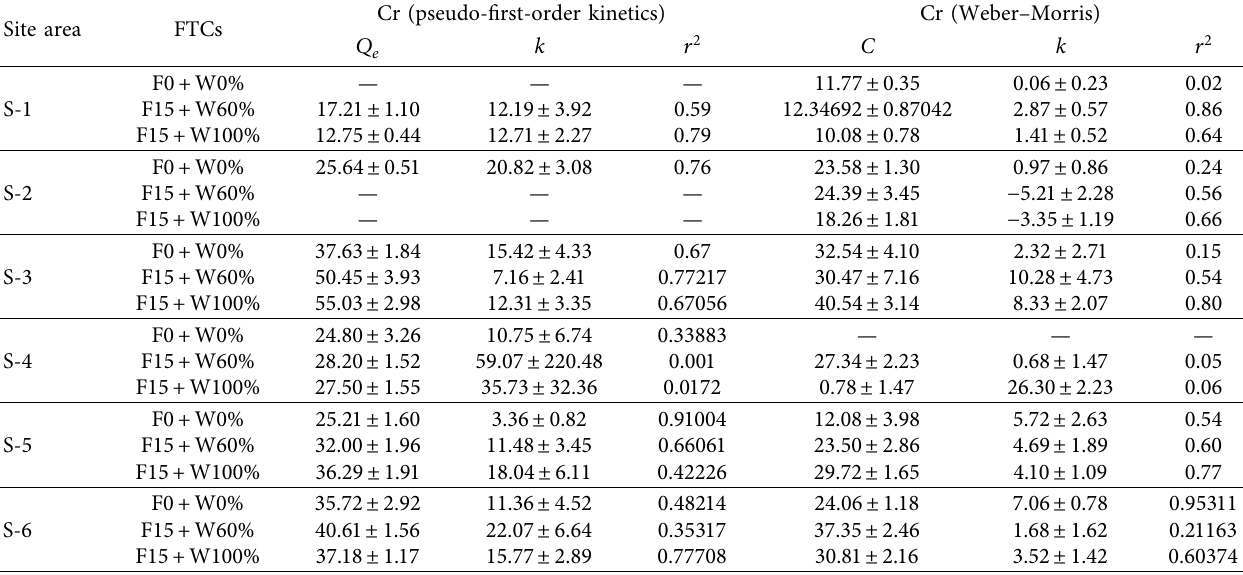
Table 4: Pseudo-first-order and Weber–Morris parameters of Cr in soils under different freeze-thaw